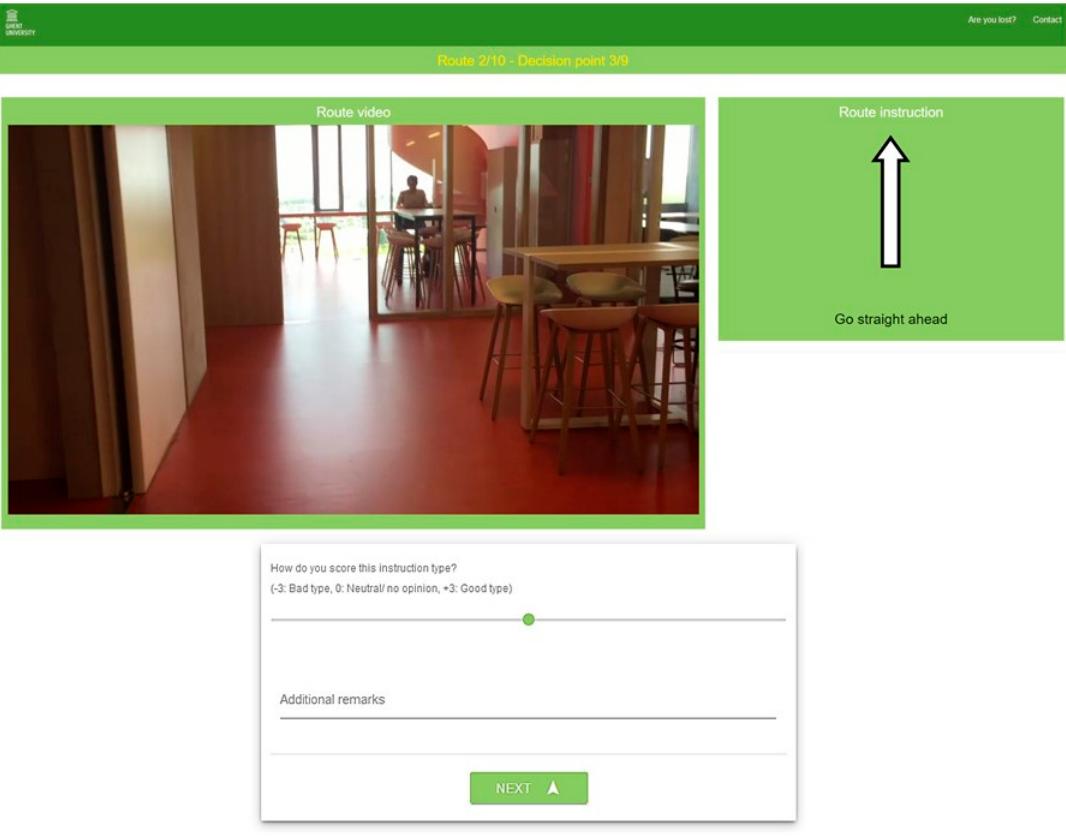
Figure 4. Sample question of the online survey with instruction type symbol + text (ST).